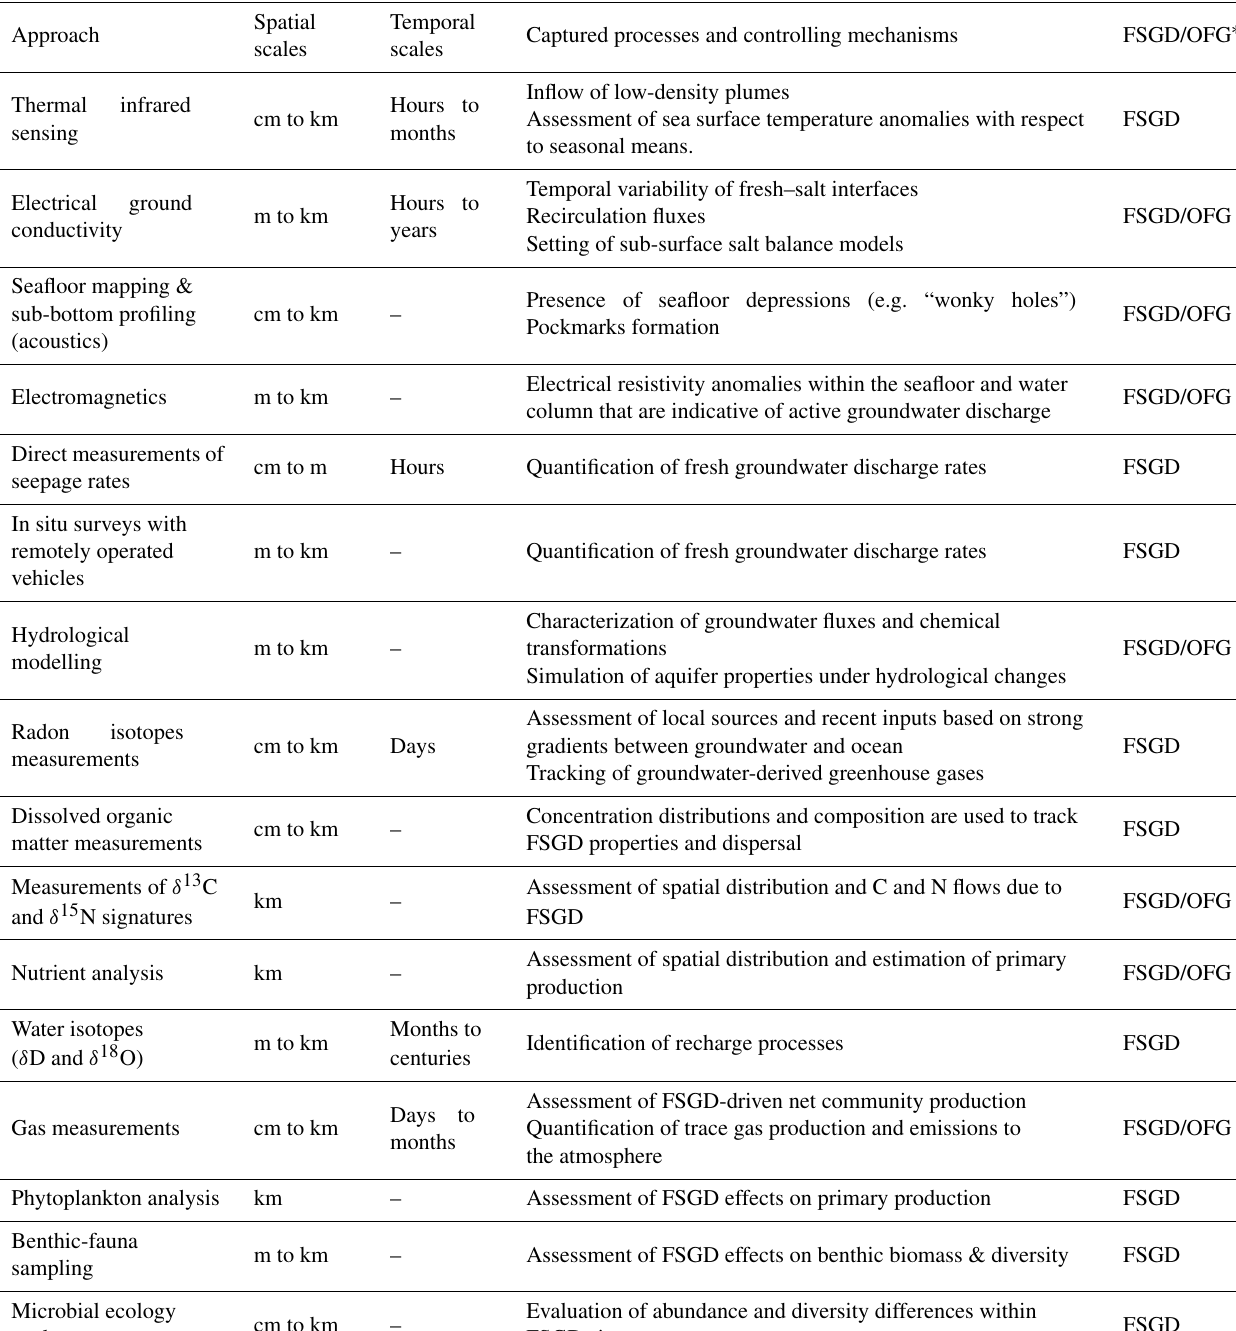
Table 2. Commonly used methods for investigating groundwater fluxes and